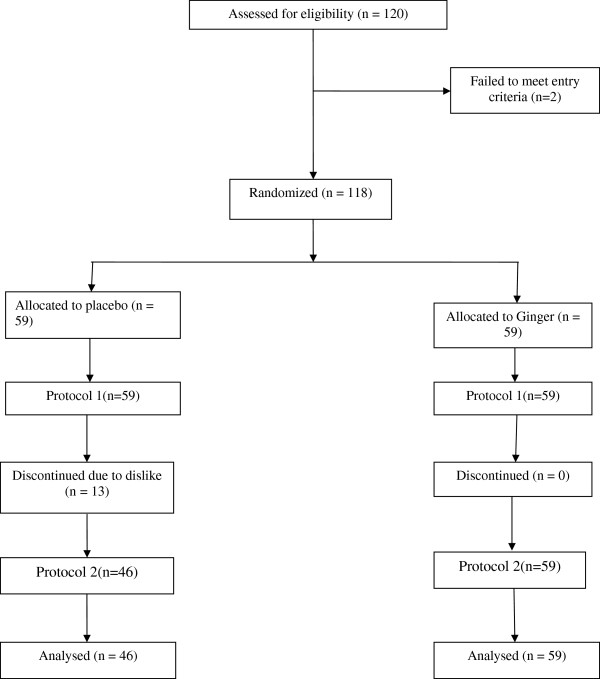
The trial flowchart.